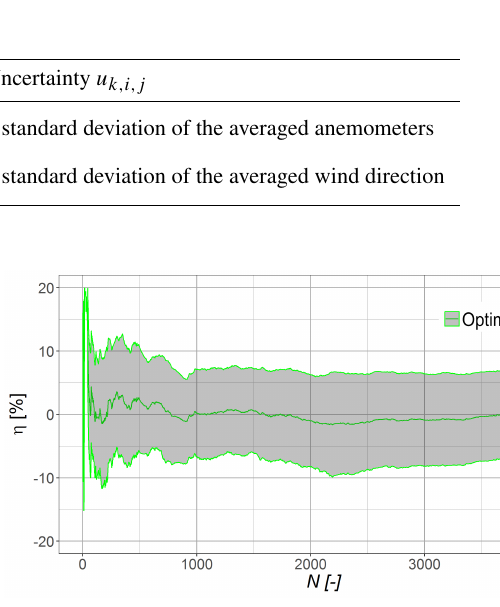
Figure 4. Underperformance indicator η with uncertainty margin as a function of the number of measurement values N . Derived with the calibrated model at a turbine in triple